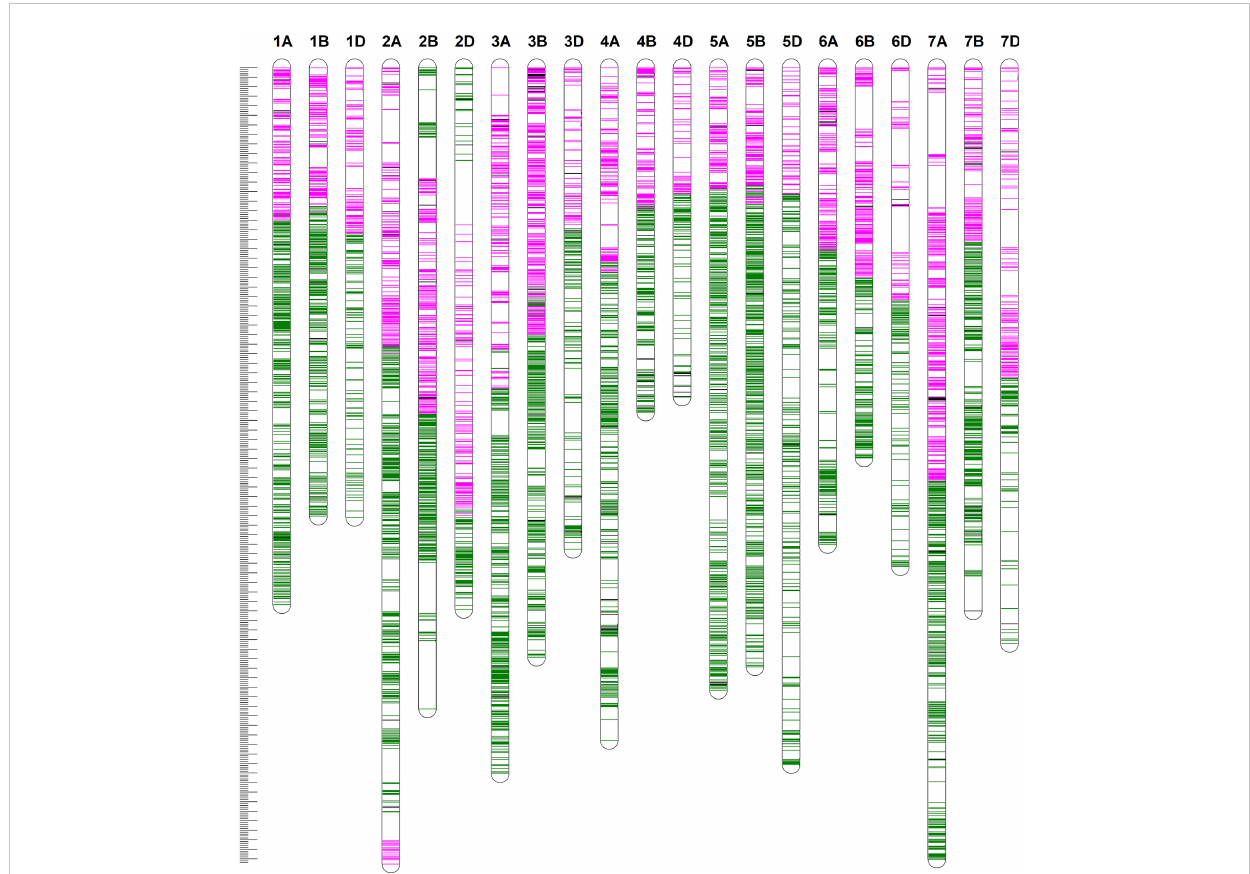
FIGURE 3 The high-density genetic linkage map of Xiaoyan 54/Jing 411 RIL population. For the redundant loci that showed co-segregation in the 182 RILs, only one unique informative marker is shown. The positions of the marker loci are indicated using a ruler on the left side. The names of the marker loci are listed to the right of the corresponding chromosomes. Loci in pink were best hits to Chinese Spring (CS) reference genome of the short arm of the corresponding chromosomes. Loci in green were best hits to CS reference genome of the long arm of the corresponding chromosomes. Loci in black were